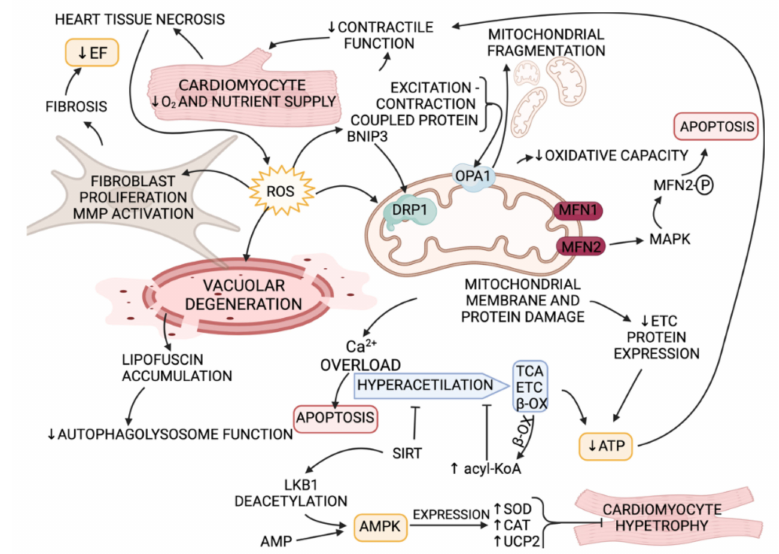
Figure 4. ROS in HFrEF pathogenesis (created with BioRender.com on 9 February 2022). Decrease in O 2 and nutrient supply in cardiomyocytes results in ROS overproduction. Increase in ROS leads to MMP activation and consequently fibroblast proliferation, vacuolar degeneration, excitation- contraction coupled protein oxidation (consequently leading to decrease in contractile function of cardiomyocytes) and oxidation of mitochondrial OMM and IMM proteins. OMM protein damage results in MAPK pathway activation, leading to apoptosis. IMM protein OPA1 oxidation (resulting in inhibition) with BNIP3 inhibition by ROS causes mitochondrial fragmentation. Both mitochondrial and other cytosol protein oxidation by ROS lead to decrease in ETC protein expression, resulting in ATP production decrease, resulting in poor contraction. Hyperacetylation of ETC complexes, fatty acid beta-oxidation and TCA cycle proteins lead to inhibition of its activity. SIRT, in healthy cardiomyocytes, inhibits hyperacetylation and activates AMPK-induced pathway, leading to enzyme- antioxidant synthesis which leads to hypertrophy inhibition. Excess of ROS inhibits beneficial SIRT effects. (EF—ejection fraction; MMP—matrix metalloproteinase; ROS—reactive oxygen